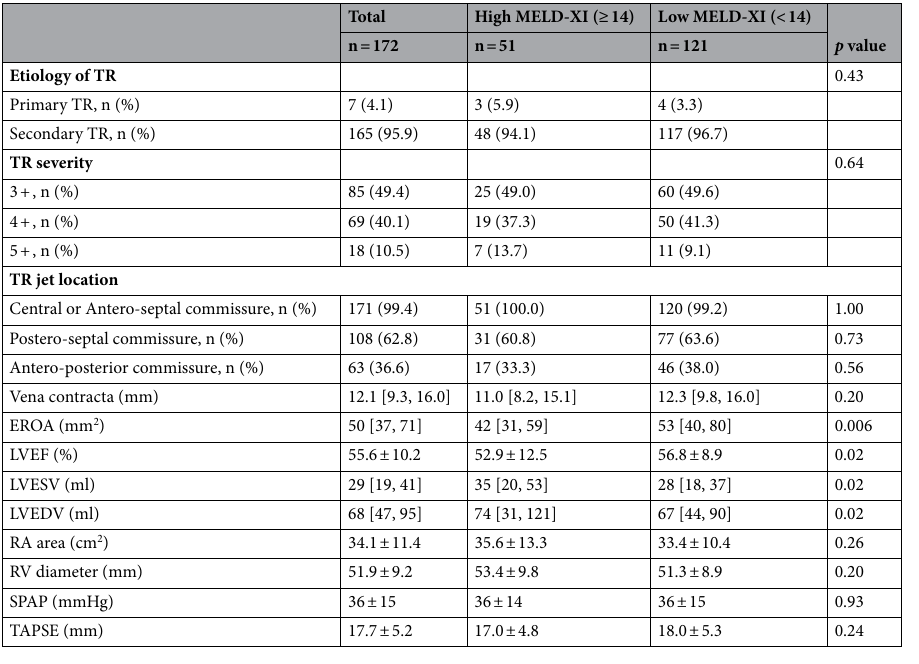
Table 2. Echocardiographic findings. Values shown are either n (%), mean ± SD, or median [interquartile range]. Legends: MELD-XI score = Model for End-stage Liver Disease eXcluding International normalized score; TR = tricuspid regurgitation; EROA = effective regurgitant orifice area; LVEF = left ventricular ejection fraction; LVEDV = left ventricular end-diastolic volume; LVESV = left ventricular end-systolic volume; RA = right atrium; RV = right ventricle; SPAP = systolic pulmonary artery pressure; TAPSE = tricuspid annular plane systolic